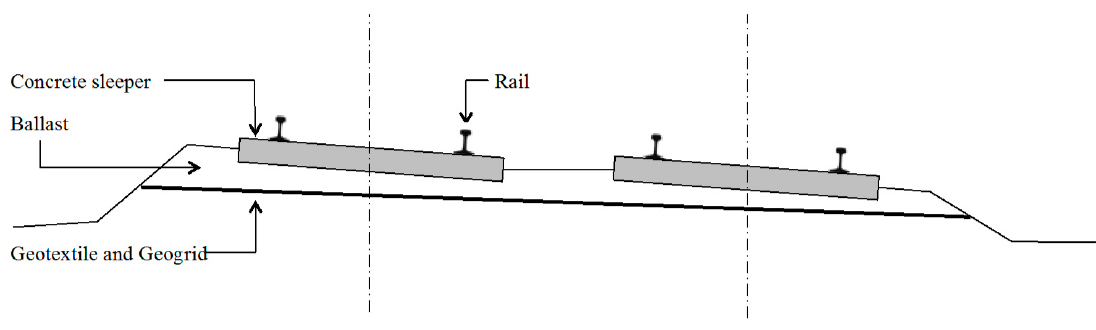
Figure 1. Cross-section of the rehabilitated rail track (adapted from Neves et al. [35]).